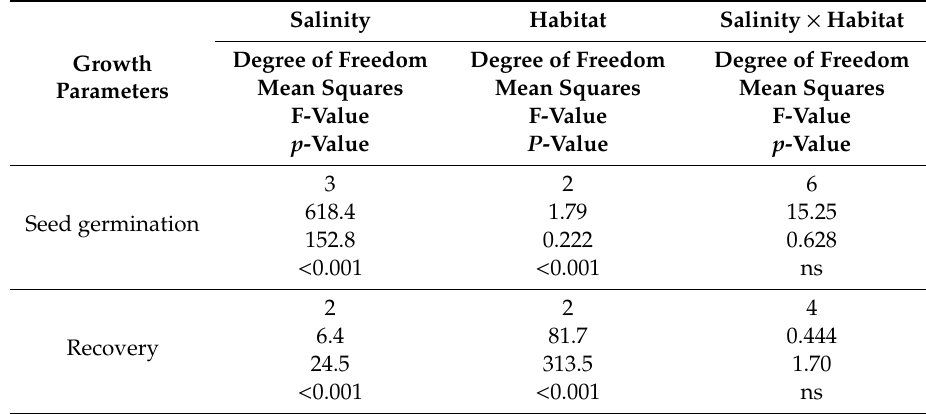
Table 1. Two-way ANOVA analysis showing the mean squares, F and p -values of the e ff ects of salinity, maternal habitat and their interaction on all studied